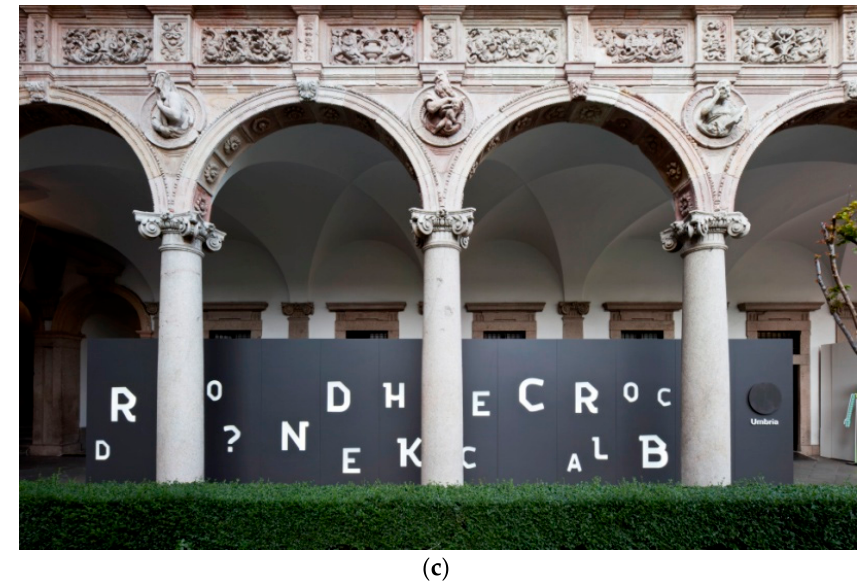
Figure 7. ( a ) Milan, Brera palace, Teatro delle immagini (ABAPG, UNIPG, 2013); ( b ) Milan, Expo 2015 , Italia Pavilion, Convivium 2.0 (ABAPG, UNIPG, 2015); ( c ) Milan, Ca’ Granda, Scorched or Blackened (ABAPG, UNIPG,